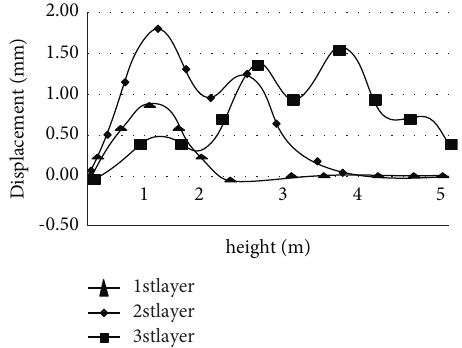
Figure 2: Displacement variation of the first three layers of the model.